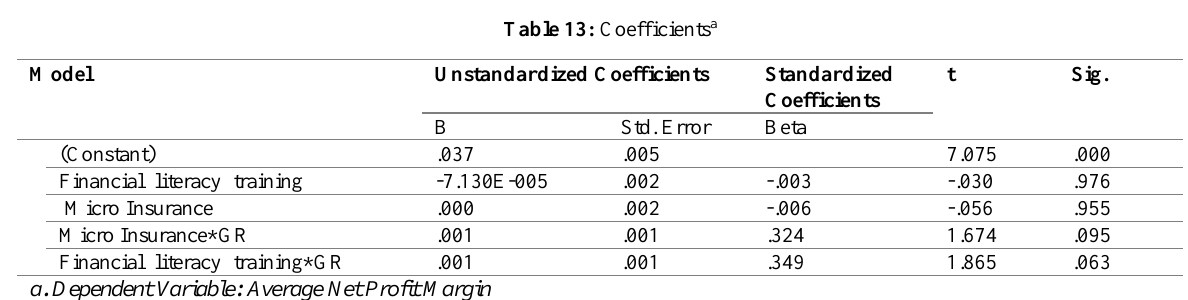
Table 13: Coefficients